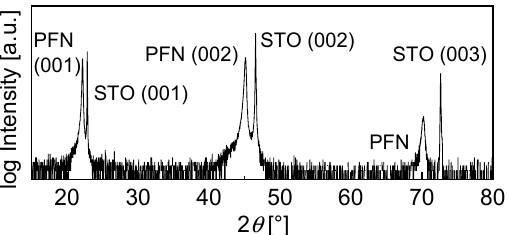
Figure 2. θ -2 θ XRD spectra of the PFN film deposited on an STO (001) substrate via PLD.